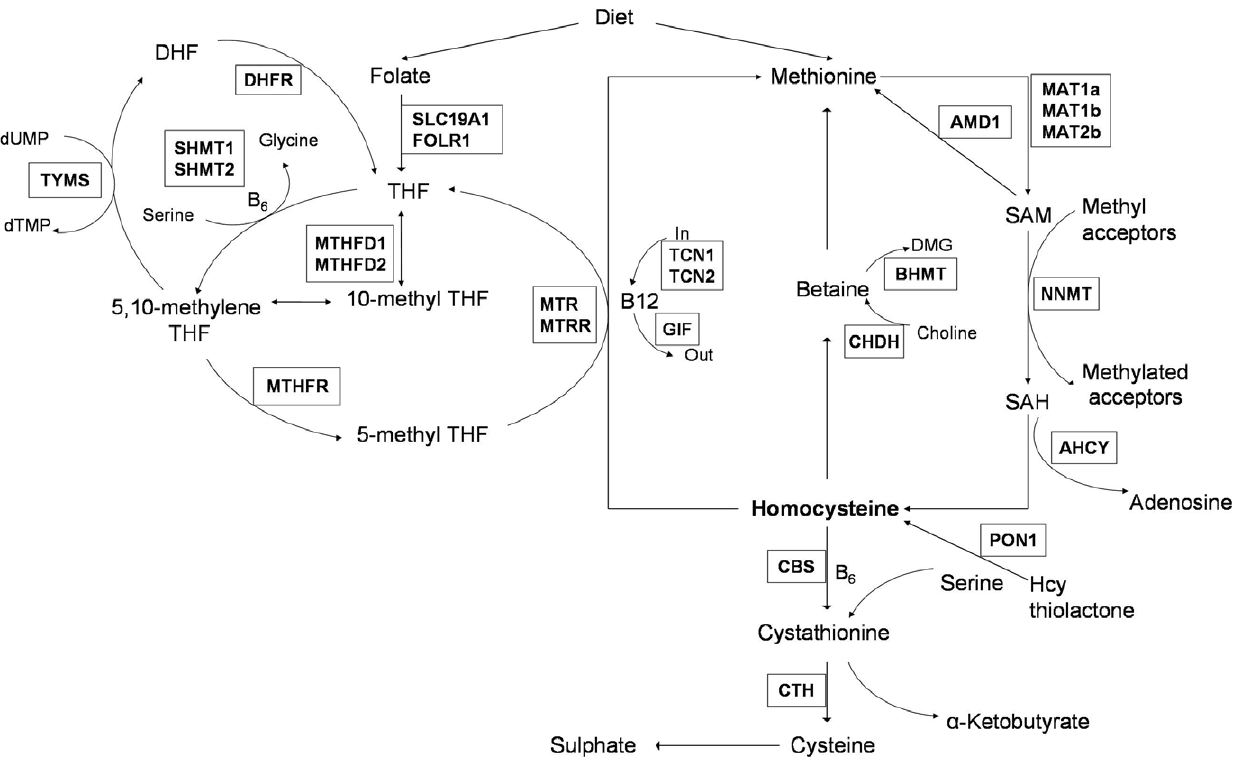
Figure 1. Homocysteine Metabolic Pathways. For gene names, refer to Table S2 .(Figure adapted from Souto JC, Blanco-Vaca F, Soria JM, Buil A, Almasy L, et al. (2005) A genomewide exploration suggests a new candidate gene at chromosome 11q23 as the major determinant of plasma homocysteine levels: results from the GAIT project. Am J Hum Genet 76: 925-933.)